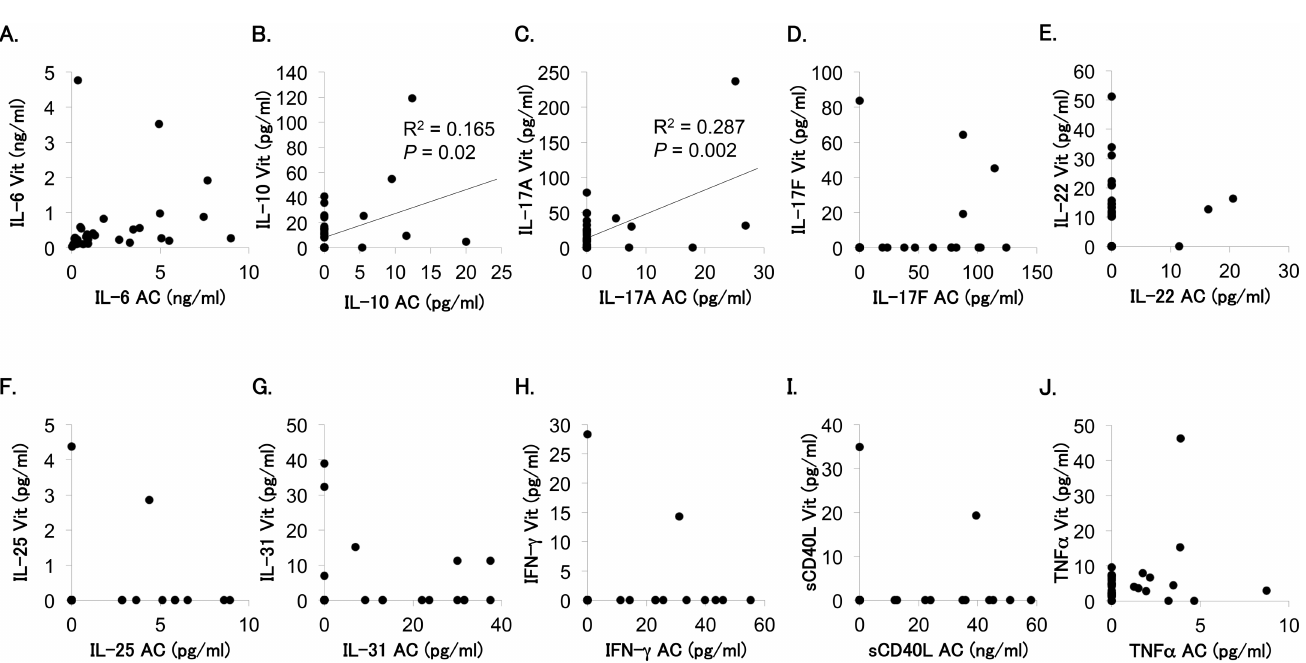
Fig 2. Association of cytokine levels in aqueous humor and vitreous fluid of patients with proliferative diabetic retinopathy. Correlation of aqueous level (AC, x-axis) vs. vitreous level (Vit, y-axis) for each cytokine was analyzedby Spearman’scorrelation coefficient test. (A) IL-6: y = 0.45 + 0.08x, R 2 = 0.039, P = 0.284; (B) IL-10: y = 10.4 + 1.99x, R 2 = 0.165, P = 0.02; (C) IL-17A: y = 14.9 + 3.27x, R 2 = 0.287, P = 0.002; (D) IL-17F: y = 3.66 + 0.09x, R 2 = 0.042, P = 0.269; (E) IL-22: y = 10.8 + 0.03x, R 2 = 0.0001, P = 0.956; (F) IL-25: y = 0.24–0.001x, R 2 = 0.00001, P = 0.988; (G) IL-31: y = 4.08–0.04x, R 2 = 0.003, P = 0.775; (H) IFN- γ : y = 1.41–0.004x, R 2 = 0.0001, P = 0.9519; (I) sCD40L:y = 1.58 + 0.03x, R 2 = 0.009, P = 0.617; and (J) TNF α : y = 4.42 + 0.99x, R 2 = 0.059, P =